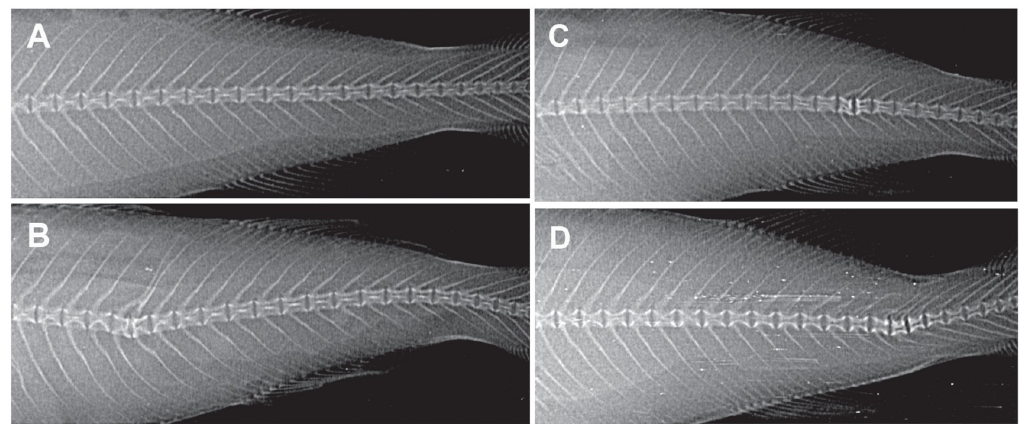
Fig 11. X-ray pictures of haddock from Control (A), PAH (B) and Oil (C and D). The picture shows different examples of vertebral malformations; deformities in vertebral 25–27 (B), 34–36 (C) and 36–39 (D).